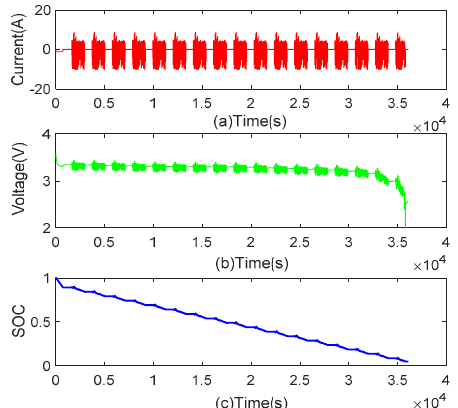
Figure 3. Measured and calculated battery response in the hybrid pulse test: ( a ) current profiles; ( b ) voltage profiles; ( c ) SOC profiles.